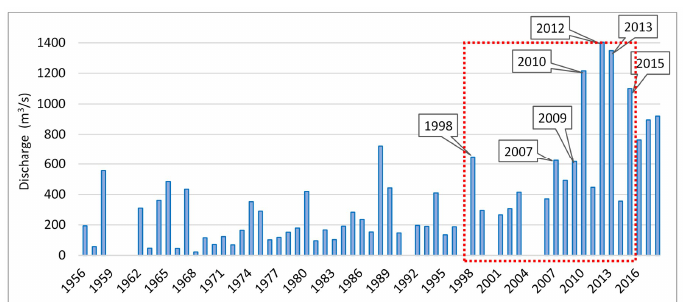
Figure 2. Time series of annual maximum discharge (AMAX) of the gauging station of Garbey Kourou [32]; in the red dotted box are reported the years analyzed in the ANFD.